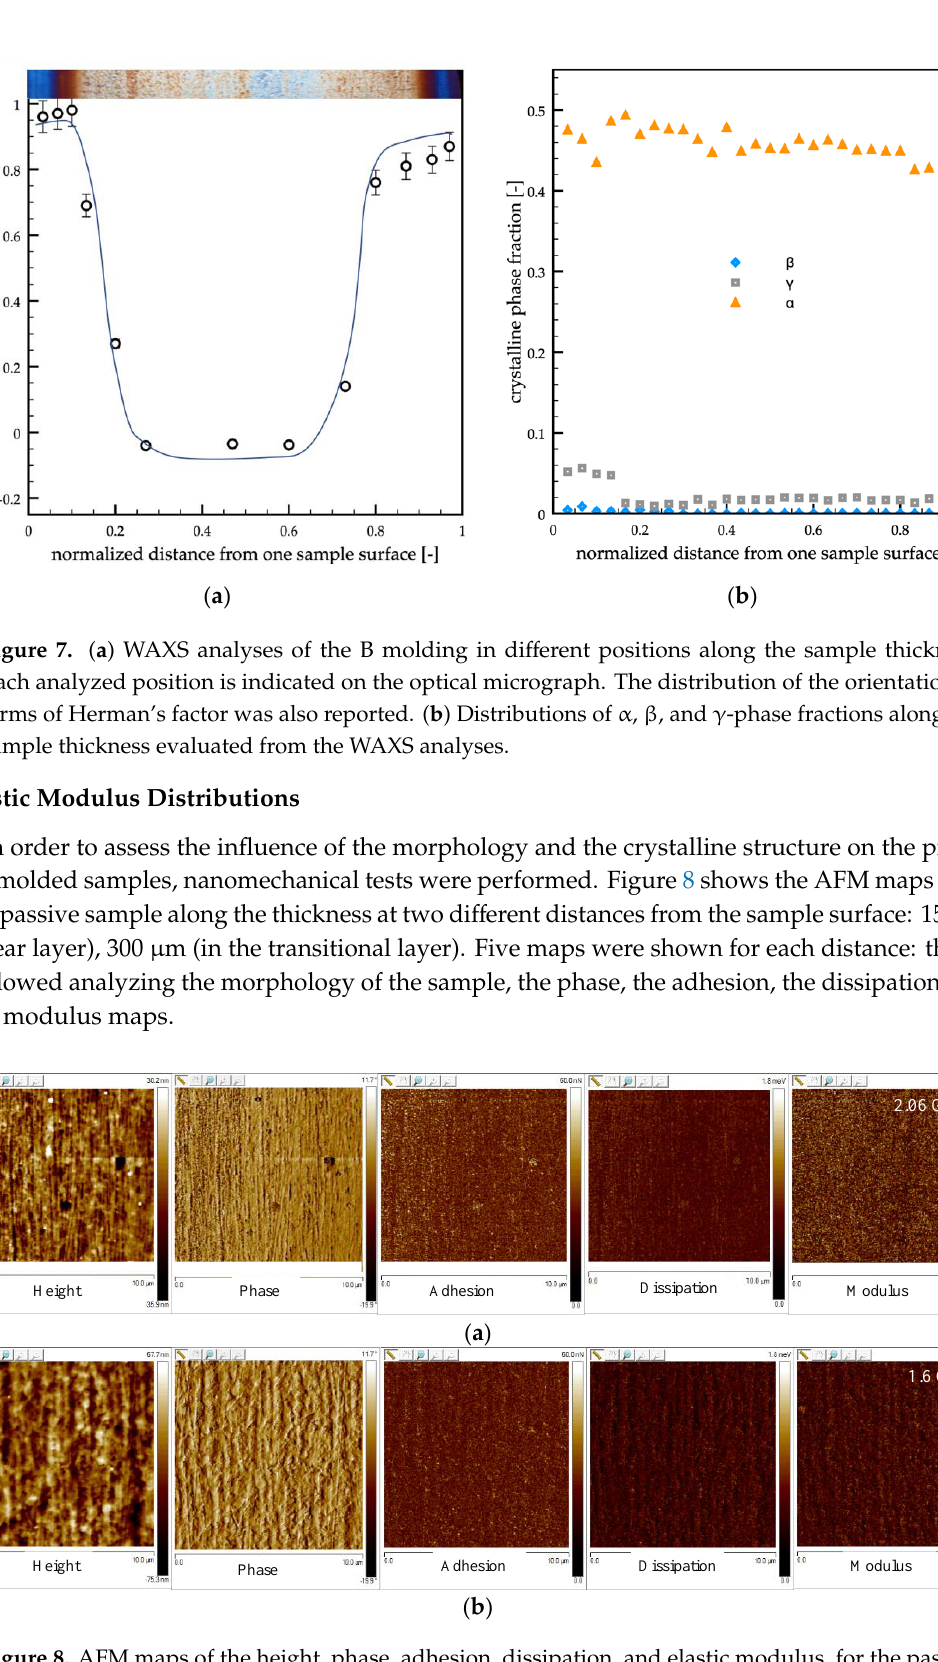
Figure 8. AFM maps of the height, phase, adhesion, dissipation, and elastic modulus, for the passive sample, acquired along the sample thickness at different distances from the surface: ( a ) 150 µm, namely the shear layer; ( b ) 300 µm, namely the transition layer.